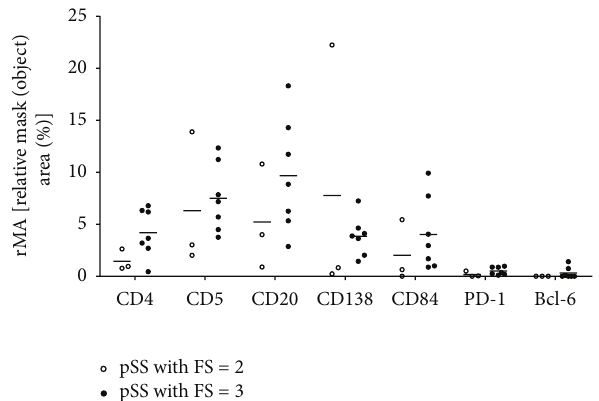
Figure 3: Plots indicating the distribution of T, B, and plasma cell markers with a special emphasis on T FH -related molecules in the inflammatory infiltrates in the two subgroups. Measurements were performed on digitalized slides with the HistoQuant module of Pannoramic Viewer software. The relative mask area is indicated in case of each marker that is presented on Figure 2. MA: overall mask area in mm 2 -summed area of each detected object in each layer; FA: overall field area in mm 2 ; rMA: (MA/FA) ∗ 100, relative mask (object) area in %. Horizontal lines represent the mean value of the group.